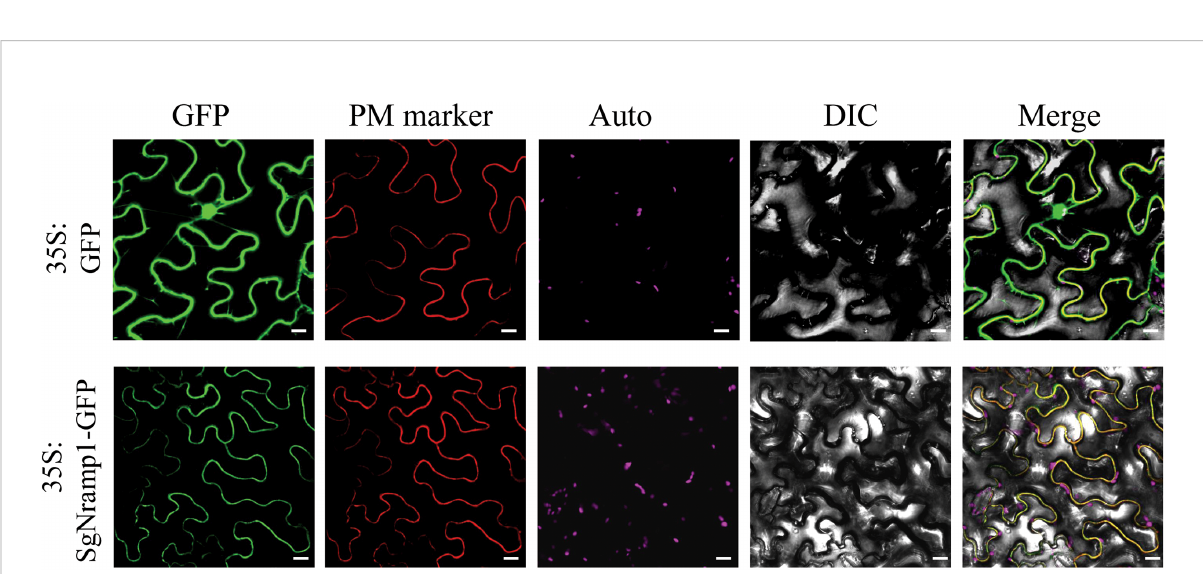
FIGURE 6 Subcellular localization of SgNramp1. The 35:SgNramp1-GFP construct and 35:GFP empty vector were transiently expressed in tobacco epidermis cells. SgNramp1 was co-expressed with the plasma membrane (PM) marker, which was fused with red fl uorescence protein (mKATE). Signals of GFP fusion protein, PM marker, chlorophyll auto fl uorescence (Auto), bright- fi eld images (DIC), and the merged images (Merge) were shown from left to right. Scale bar is 20 m m.